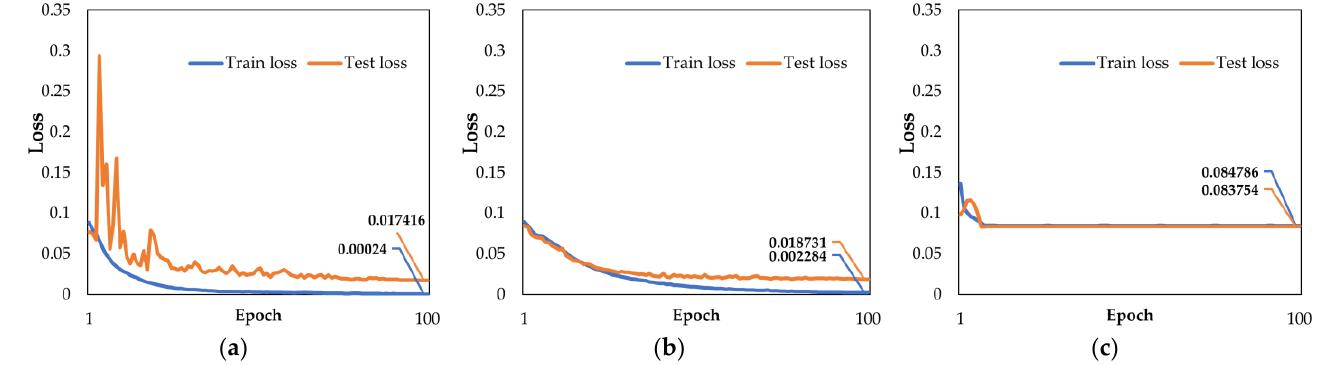
Figure 4. The evolution of the loss function during training for the Golay-6 OSA system based on Power Metric: ( a ) ResNet-34; ( b ) Alex Net; ( c ) VGG-16.